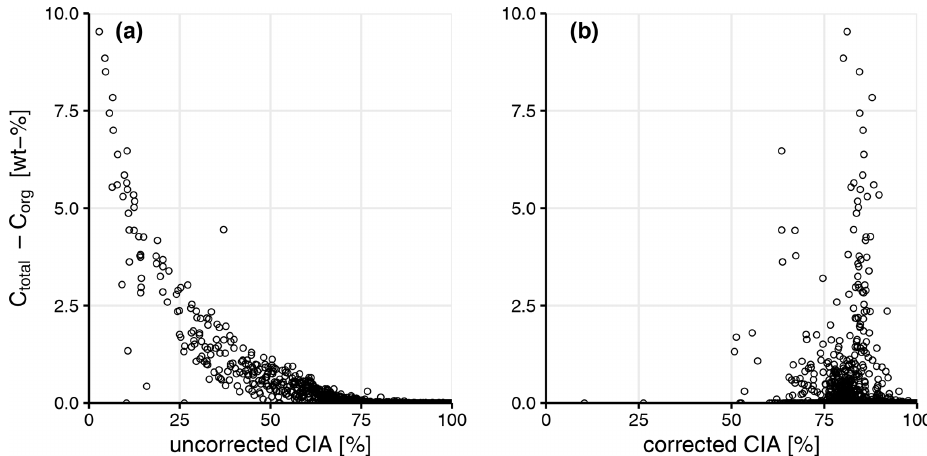
Figure A3. Scatterplot of inorganic carbon (C total –C org ; wt%), the uncorrected chemical index of alteration (CIA; percent) a ) and the CIA